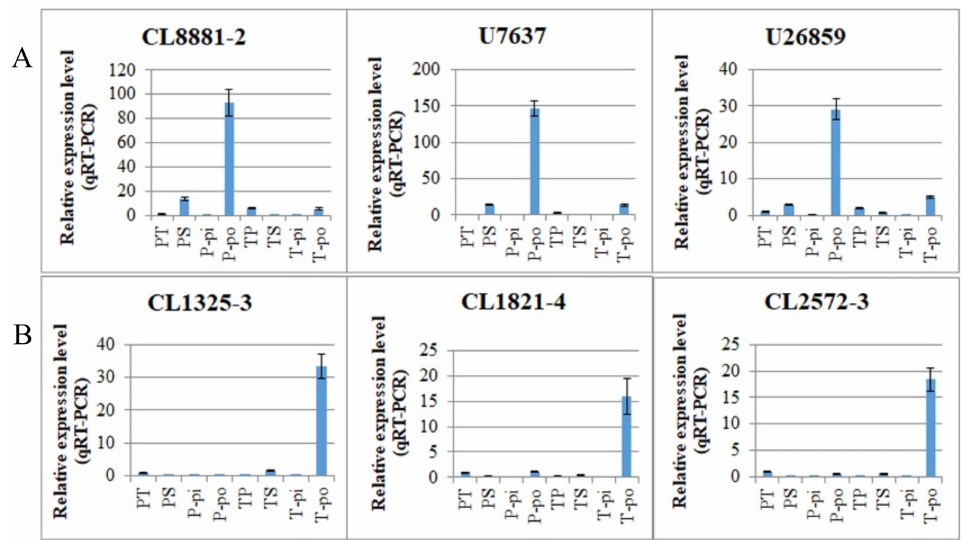
Figure 7. Expression patterns of DEGs with inverse expression patterns in PS vs. PT and TS vs. TP comparisons detected by qRT-PCR. ( A ) DEGs upregulated in the PS vs. PT comparison and downregulated in the TS vs. TP comparison were highly expressed in pin pollen; ( B ) DEGs downregulated in the PS vs. PT comparison and upregulated in the TS vs. TP comparison were highly expressed in thrum pollen. PT, pistils of pin after cross-pollination. PS, pistils of pin after self-pollination. P-pi, pin pistils without pollination. P-po, pin pollen. TP, pistils of thrum after cross-pollination. TS, pistils of thrum after self-pollination. T-pi, thrum pistils without pollination. T-po, thrum